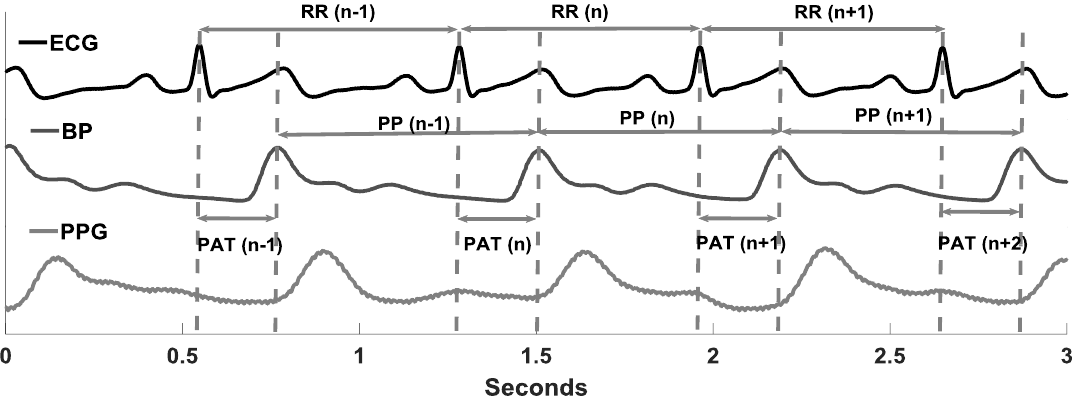
Figure 1. An example of simultaneously recorded ECG, finger blood pressure (BP), and finger photoplethysmography (PPG). The RR, peak-to-peak (PP), and pulse arrival time (PAT) time series were derived as shown in the figure. Finger PPG, although not utilized in this research, is shown to highlight morphological similarity with finger blood pressure waveform.